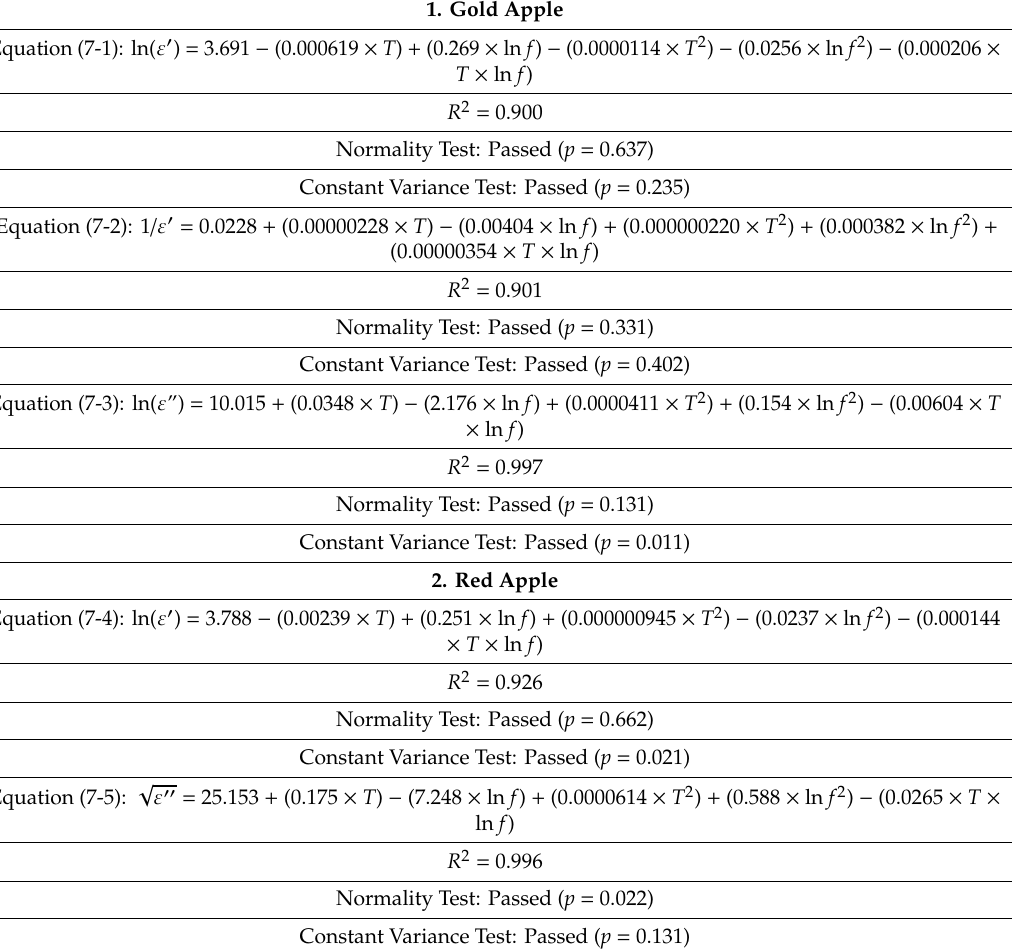
Table 7. Results and criteria for the regression analysis for the dielectric properties of five fruits, two nuts, and four insect larvae. 1. Gold